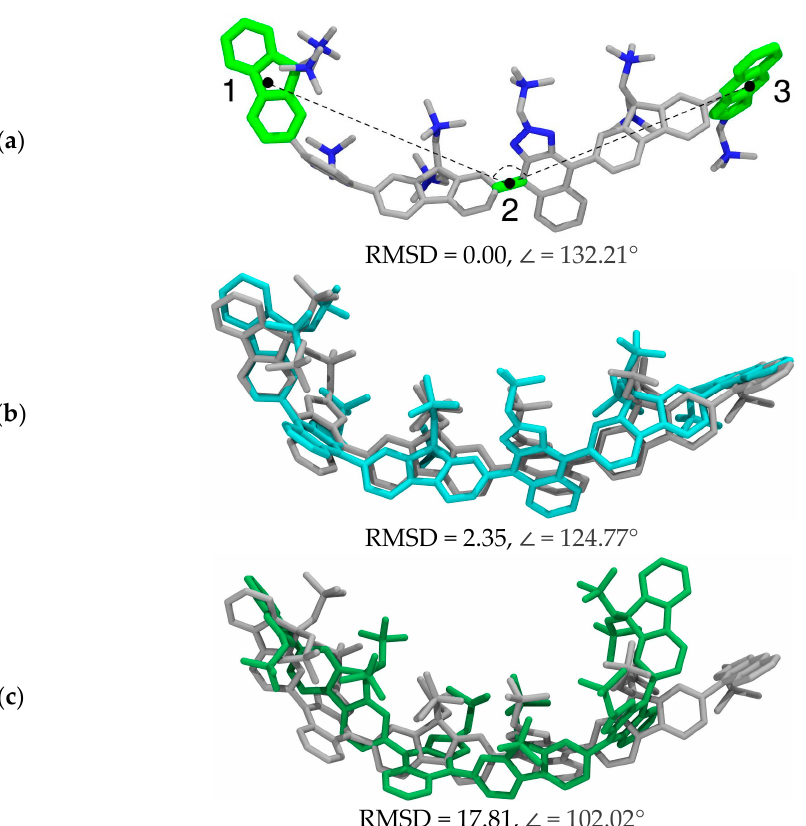
Figure 6. ( a ) The bending angle ( ∠ ) calculated as the angle between the vectors of the external fluorene mass centers and RMSD of the trimer in ( b ) T-Cu8-4 and ( c ) T-Cu8-5: copper and bromine atoms were excluded from the analysis. The optimized structure of the trimer is colored in gray. Table 2. Turbidity for different concentrations of CPE or CuNP/CPE after 24 h in the dark. Bacterial